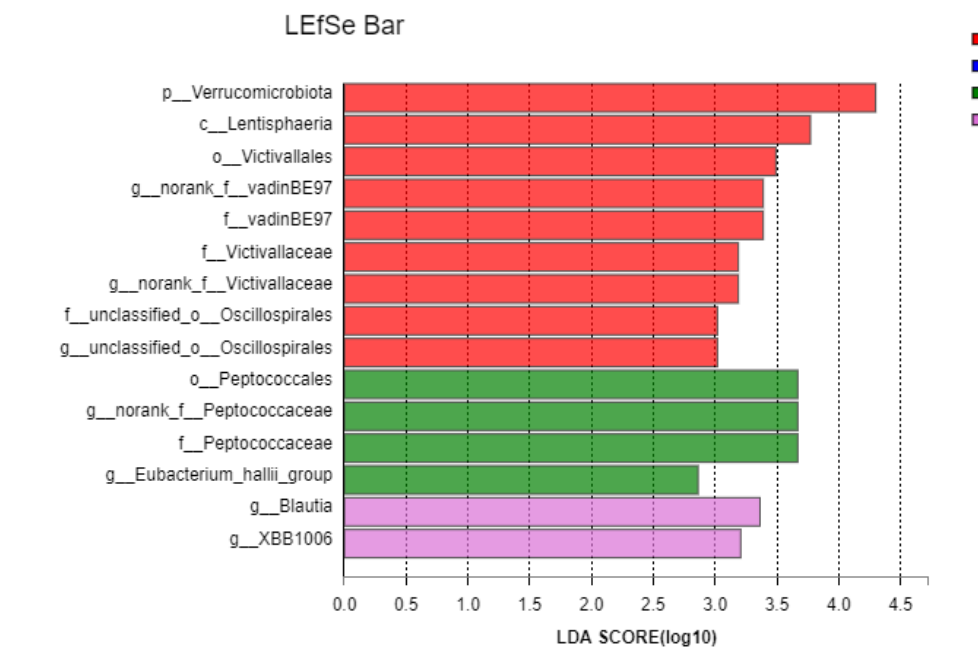
Figure 5. Biomarker bacterial genera in different treatment groups as revealed by linear discriminant analysis (LDA) Effect Size (LEfSe) based analysis (LDA score > 2.5).